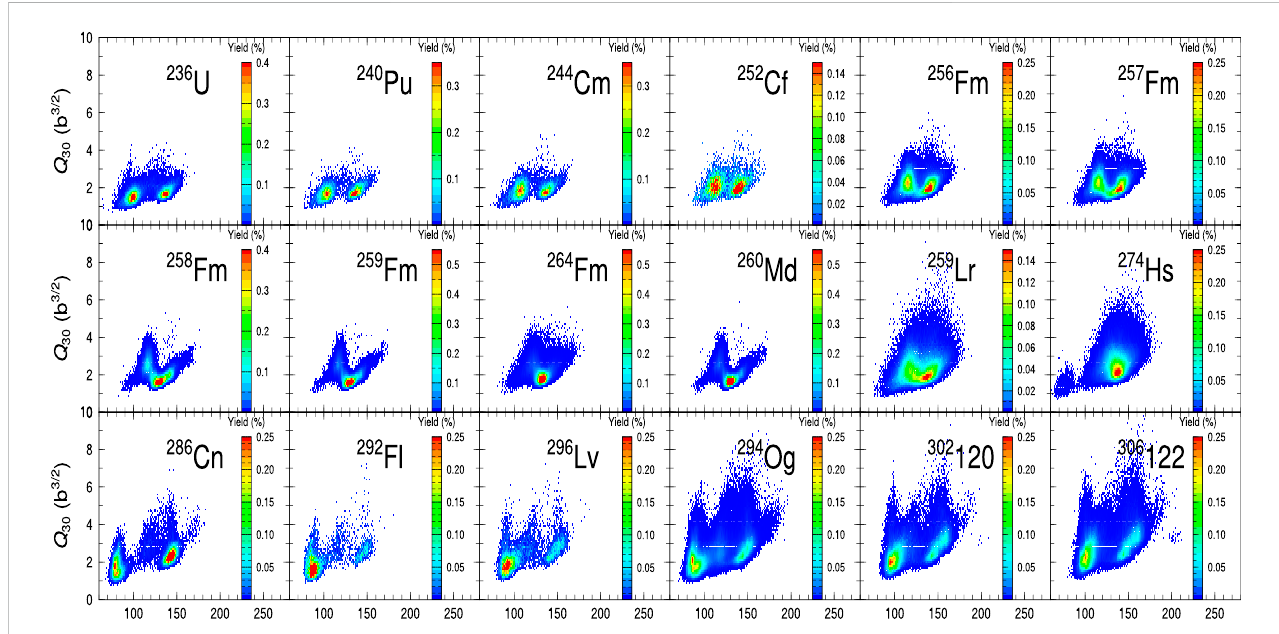
FIGURE 6 Octupolemoment( Q 30 )distributionsof 236 Uto 306 122atlowexcitationenergyjustabovetheir fi ssionbarrierheightusingthefour-dimensionalLangevin